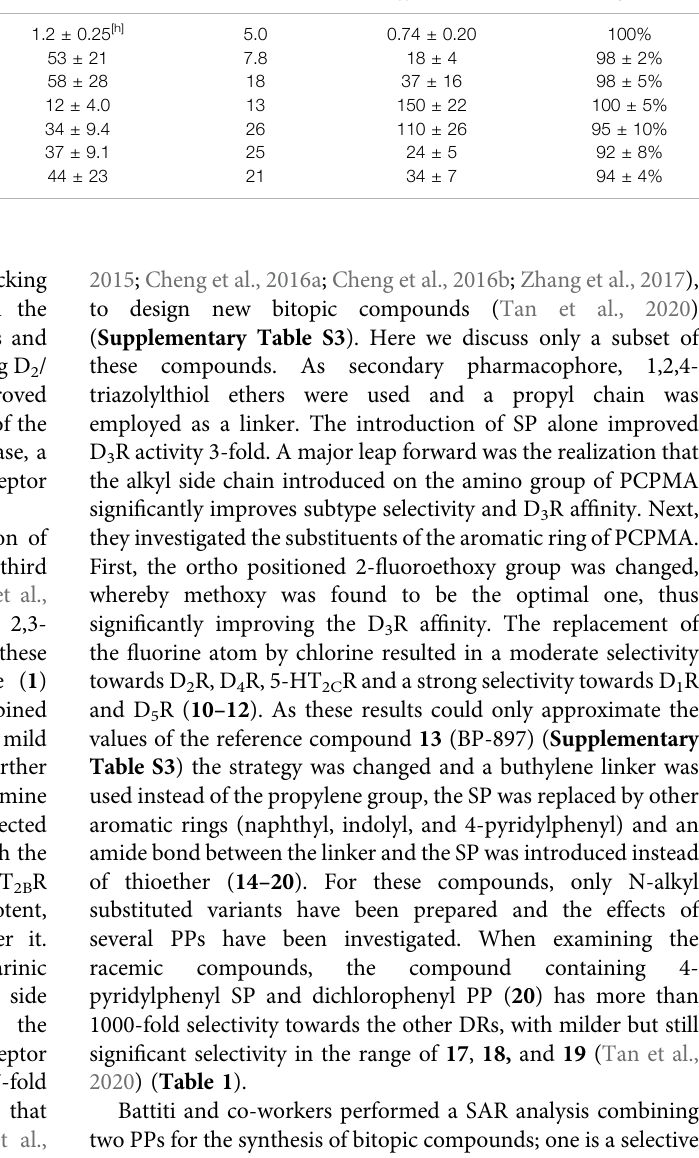
TABLE 2 | NTS1 and NTS2 receptor-binding data for bitopic ligands (Kling et al., 2019).